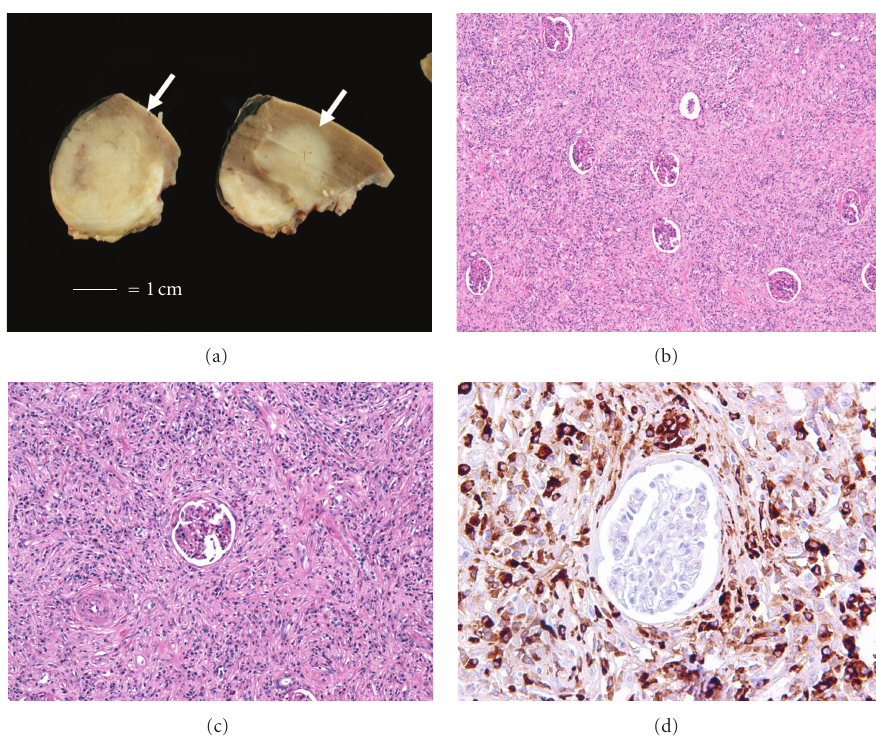
Figure 1: (a) Gross examination from the partial nephrectomy specimen showing a relatively well circumscribed, firm, homogenous, white mass in the renal hilum (white bar = 1cm), (b) low power showing a di ff use lymphoplasmacytic infiltrate associated with fibrosis that infiltrate between glomeruli, (c) medium power showing prominent fibrosis, and (d) IgG4 immunohistochemistry showing numerous IgG4+ plasma cells surrounding a glomerulus. No IgG4 positive plasma cells were identified in the